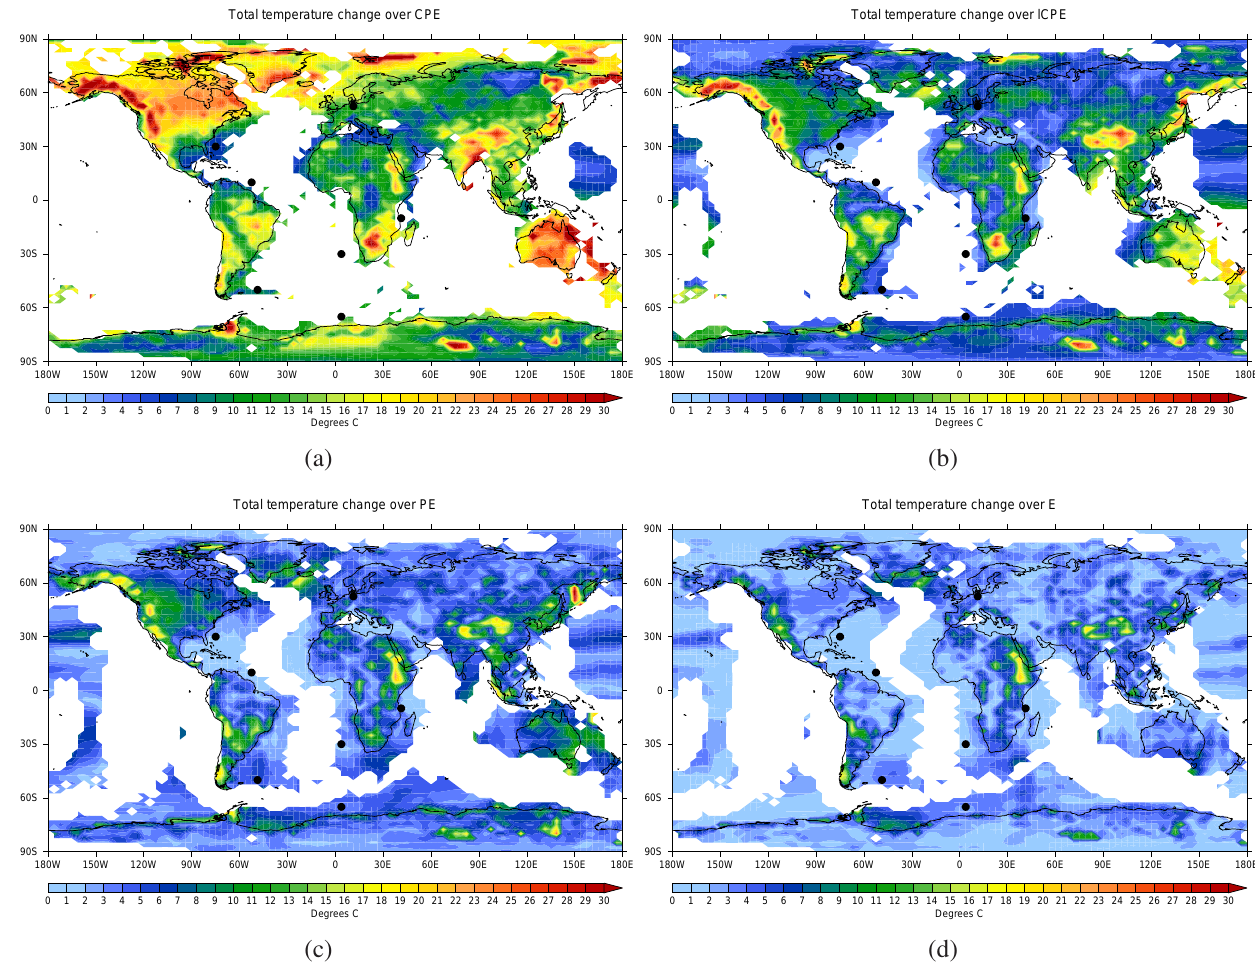
Figure 11. (a) Total temperature change across the CPE (maximum temperature in the CPE minus minimum temperature in the CPE, ◦ C) for all modern locations, due to changes in palaeogeography and solar constant. Missing data (white) is where the Getech Plc plate model indicates that the modern location was not present across all the CPE. Also shown as black dots are the seven locations in Fig. 9. CPE is defined as from the early Cretaceous (Berriasian) to the late Eocene (Priabonian). (b–d) are similar, but show the change (b) from the late Cretaceous (Cenomanian) to the late Eocene (Priabonian), (c) from the early Paleocene (Danian) to the late Eocene (Priabonian), (d) from the early Eocene (Ypresian) to the late Eocene